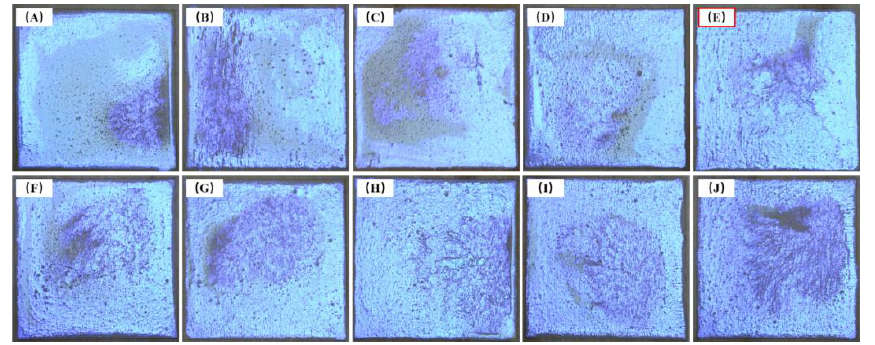
Figure 11. Photos of coatings formed by the self-assembly of PSt microspheres at different temper- atures: ( A ) 10 °C; ( B ) 20 °C; ( C ) 30 °C; ( D ) 40 °C; ( E ) 50 °C; ( F ) 60 °C; ( G ) 70 °C; ( H ) 80 °C; ( I ) 90 °C; tures: ( A ) 10 ◦ C; ( B ) 20 ◦ C; ( C ) 30 ◦ C; ( D ) 40 ◦ C; ( E ) 50 ◦ C; ( F ) 60 ◦ C; ( G ) 70 ◦ C; ( H ) 80 ◦ C; ( I ) 90 ◦ C; ( J ) 100 °C. ( J ) 100 ◦